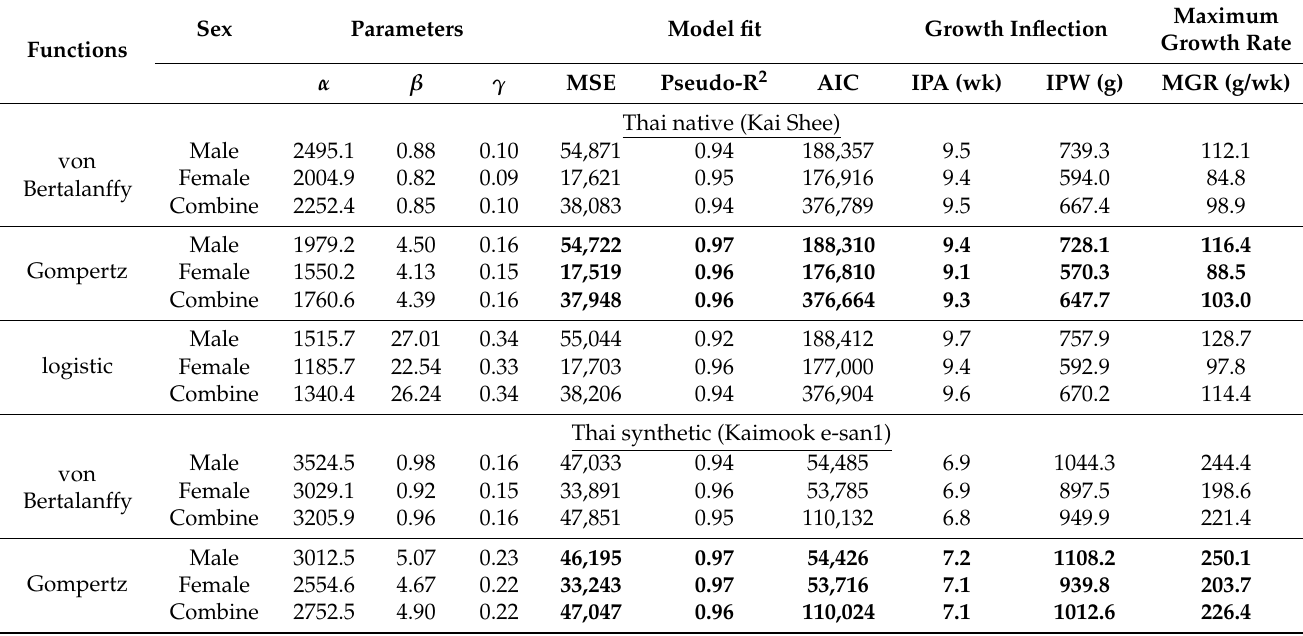
Table 2. Nonlinear regression functions used to fit the growth curves of purebred Thai native and Thai synthetic chickens.